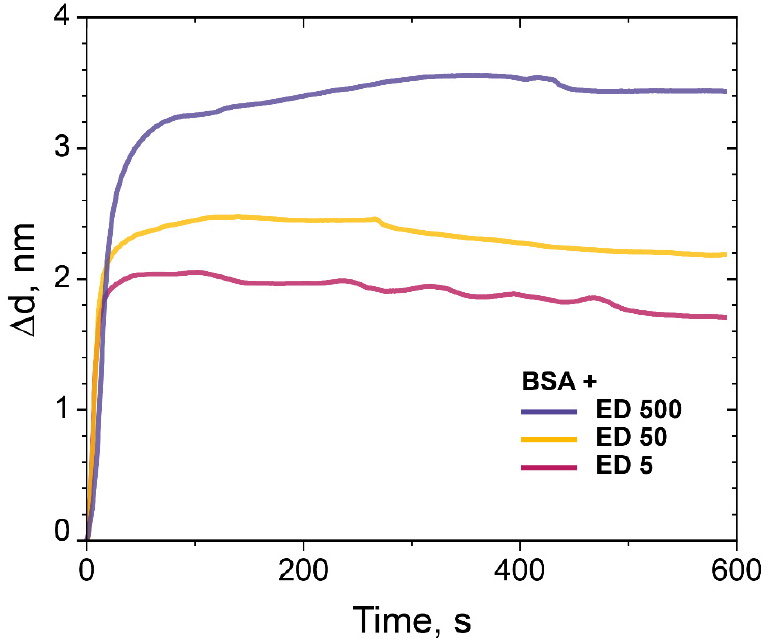
Figure 7. The change in the adlayer thickness upon binding of BSA (0.1 mg/mL) with the PC chip surface modified with ED (Mw 5 kDa, 50 kDa, and 500 kDa).